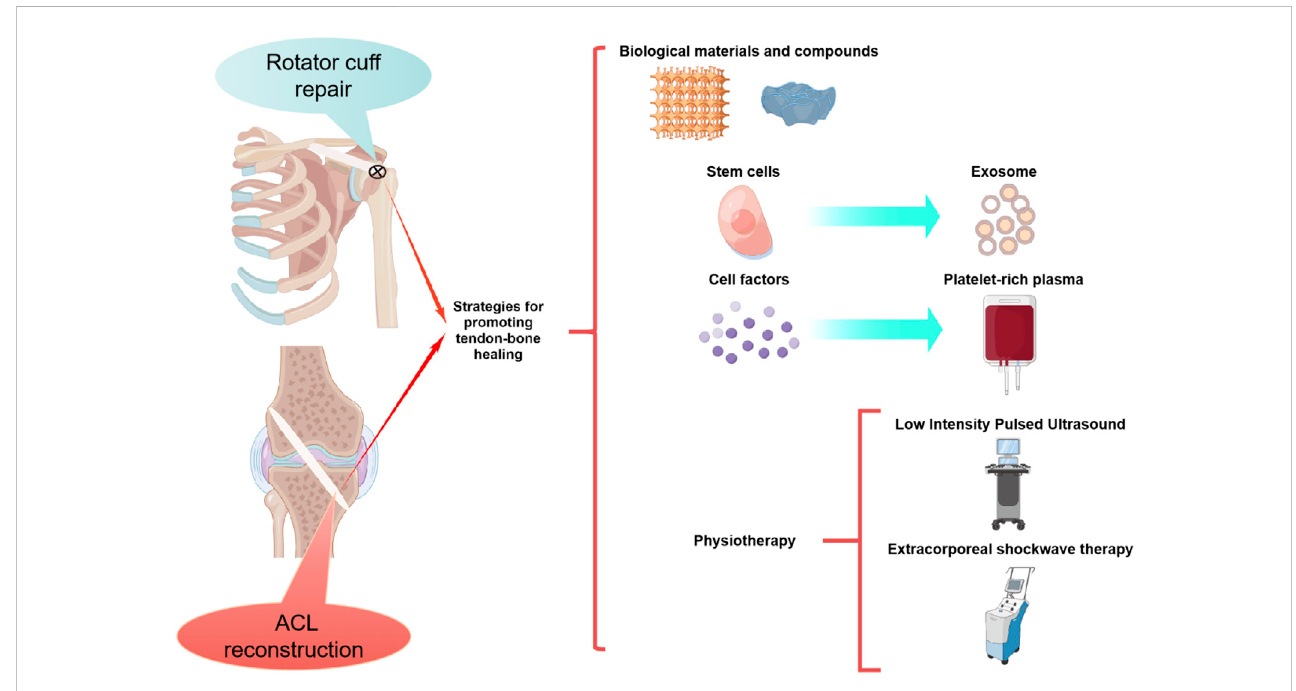
FIGURE 1 Strategies for promoting tendon-bone healing were demonstrated by